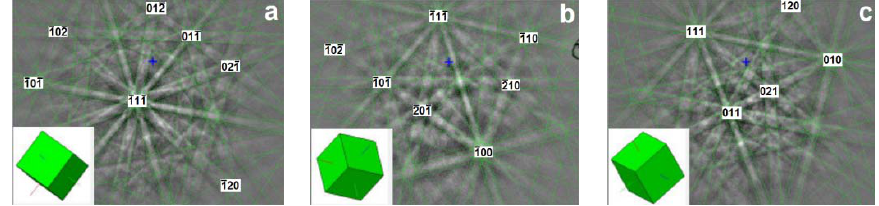
Figure 3. ( a – c ) Electron backscatter diffraction (EBSD) patterns at three different locations of Alloy P3 overlaid with simulated patterns (green lines). All three points are identified to have the same body ‐ center ‐ cubic (bcc) phase structures but different crystal orientations.